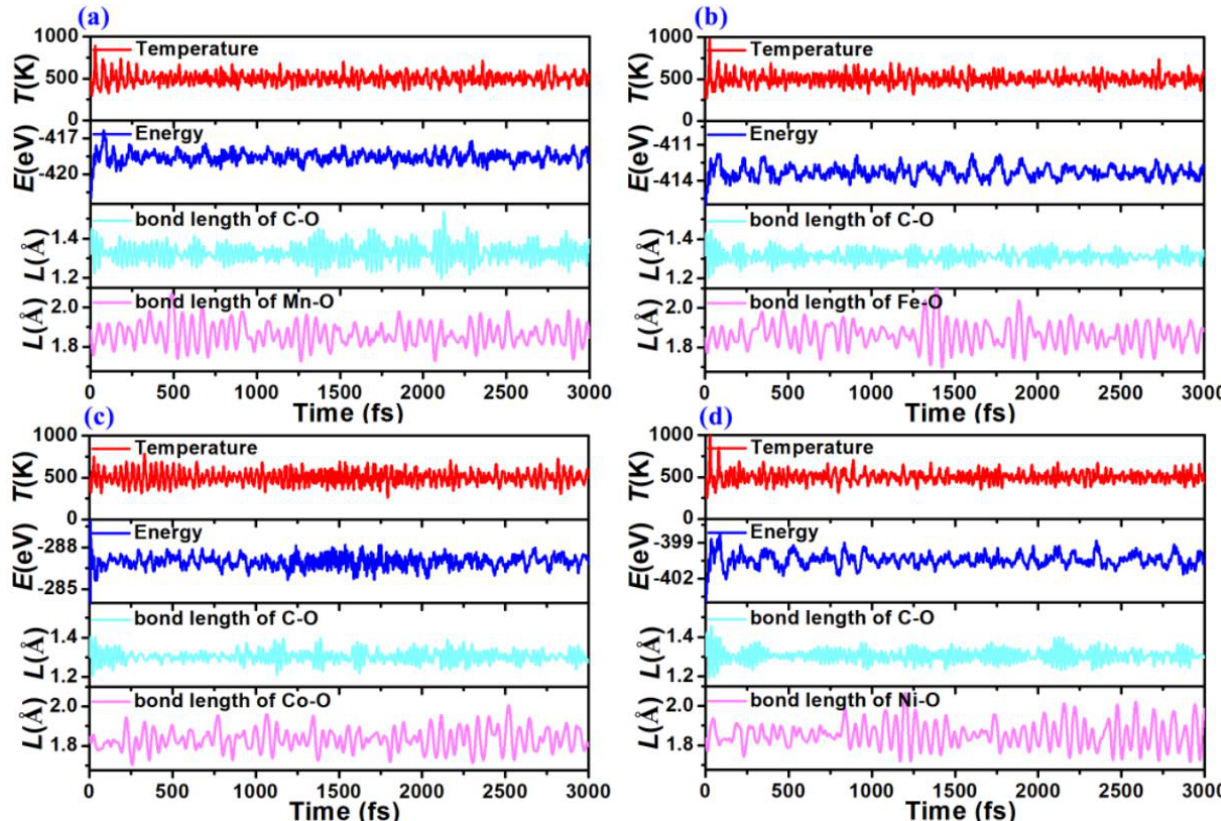
Figure 2. The AIMD results of ( a ) Mn-O-MOF, ( b ) Fe-O-MOF, ( c ) Co-O-MOF, and ( d ) Ni-O-MOF single-layer structures at 500 K during the timescale of 3 ps.